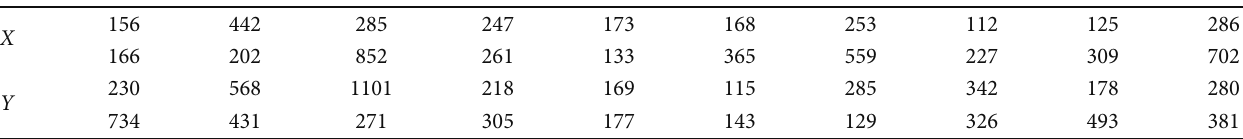
Table 7: Real data.